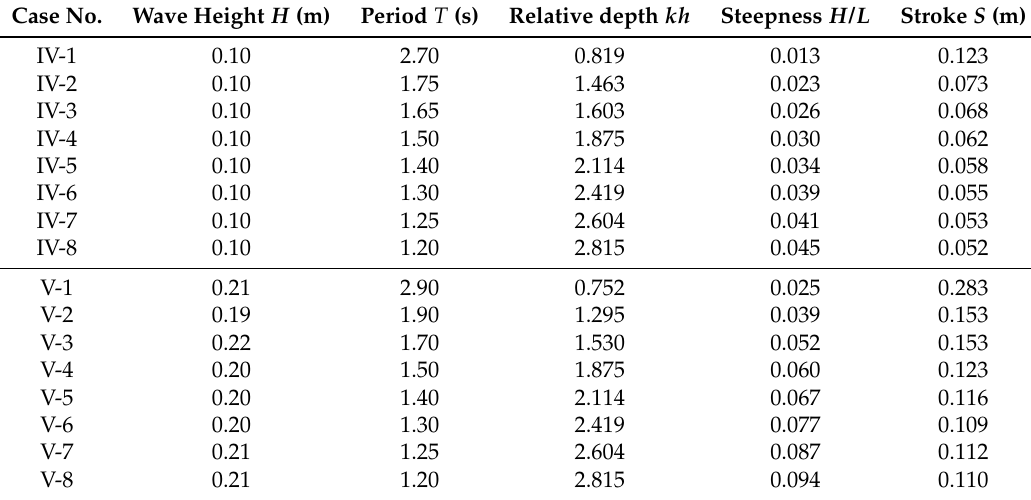
Table 6. Wave parameters in the numerical